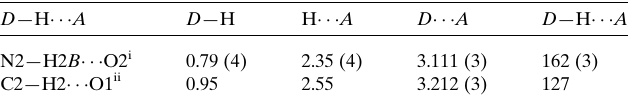
Table 1 Hydrogen-bond geometry (A˚ , (cid:3) ) for (I).